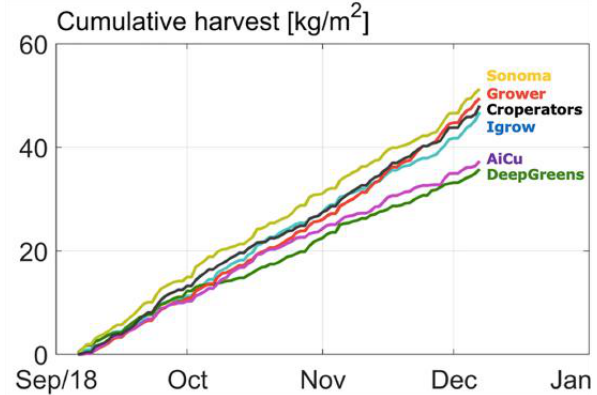
Figure 3. Cumulative cucumber production of different teams.